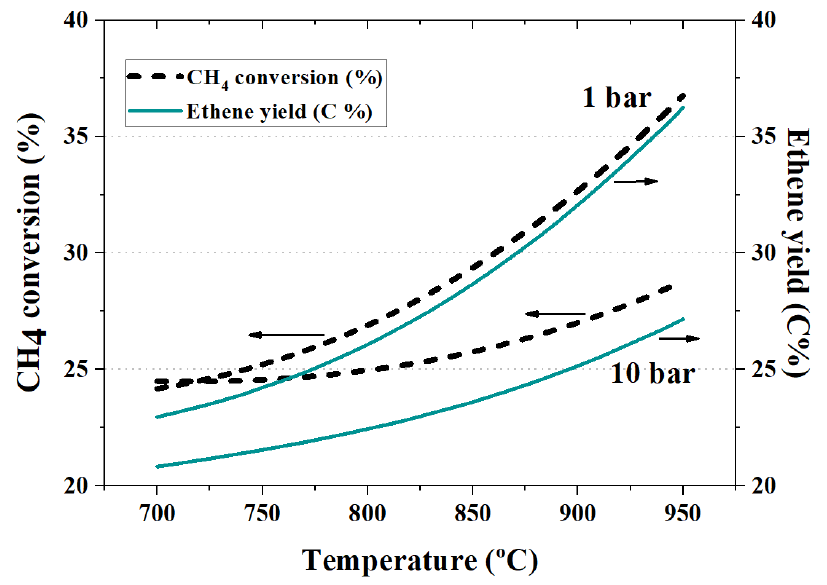
Figure 24. Thermodynamic CH 4 conversion and ethene yield as a function of temperature at the CH 4 /O 2 feed molar ratio equal to 9, and pressures of 1 and 10 bar. Equilibrium composition was calculated assuming the presence of the following six compounds: CH 4 , O 2 , H 2 , H 2 O, C 2 H 6 and C 2 H 4